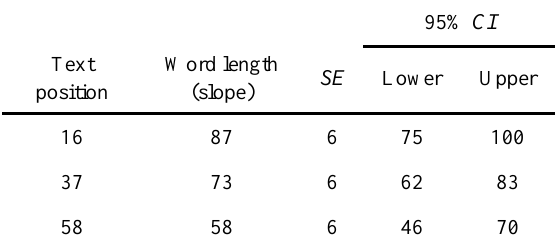
Table A8. Total reading time per word: Interaction of word length and serial text position.